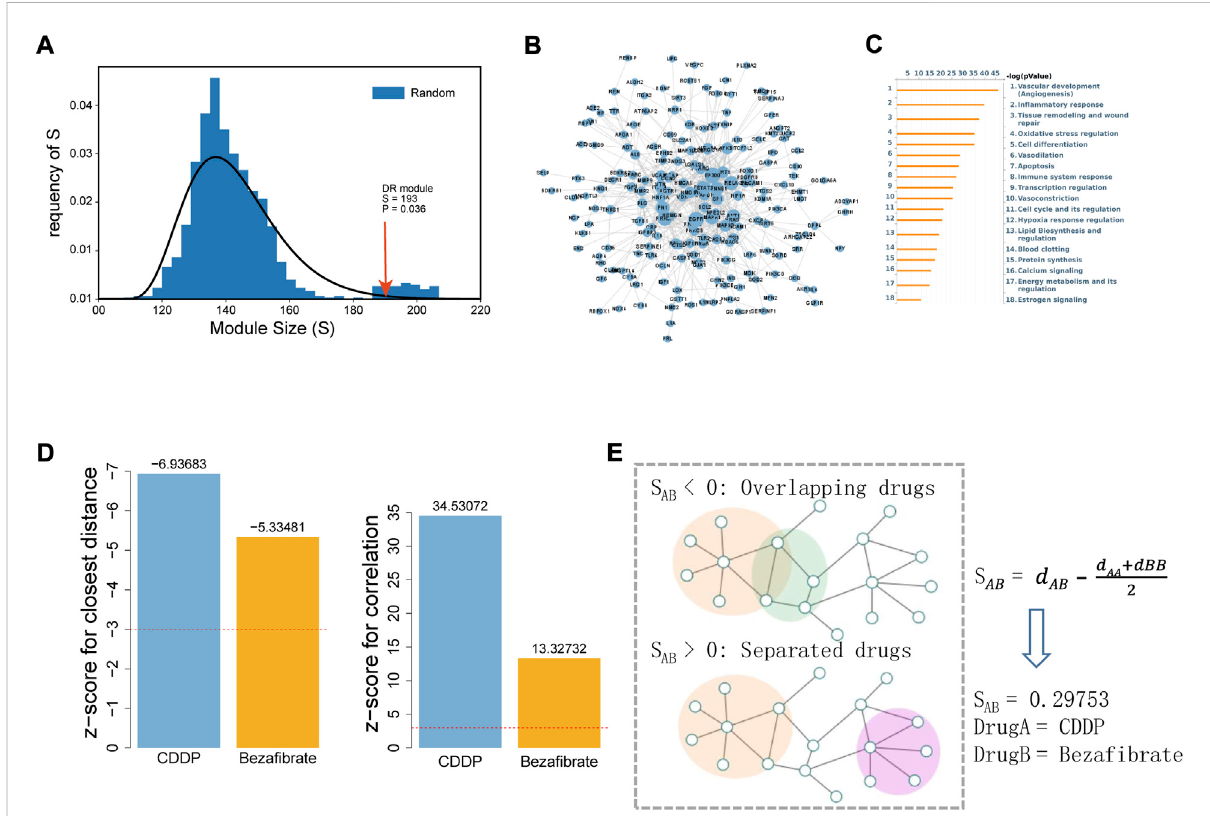
FIGURE 1 Correlation analysis between DR and the drugs (CDDP and BZF) based on the human interactome network. (A) LCC analysis of DR-associated genes. Size of the LCC module of DR is shown by the arrow ( p -value was calculated with 1000 permutations). (B) Interaction network of LCC genes for DR visualized by Cytoscape. (C) Enrichment analysis of LCC by the MetaCore database. The 18 most signi fi cant biological processes are shown sorted by p -value. (D) Ef fi cacy of CDDP and BZF on DR evaluated by network proximity (left) and correlation (right). The Z-score was used to evaluate their signi fi cance, and a Z-score of < 3 (for closest distance) or > 3 (for correlation) was considered to be signi fi cant. (E) Network proximity analysis of drug target modules A and (B) . S AB was used to evaluate the network proximity between target modules A and (B) . d AA and d BB are the shortestdistanceswithintheinteractomefortargetmodulesAandB,respectively,and d AB istheshortestdistancebetweentargetmodulesAand (B)